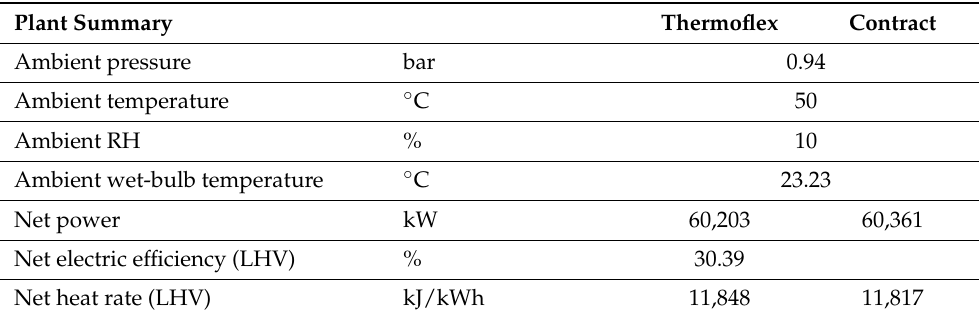
Table 1. Comparison between Thermoflex prediction and contract conditions of a GE 7001EA gas turbine.